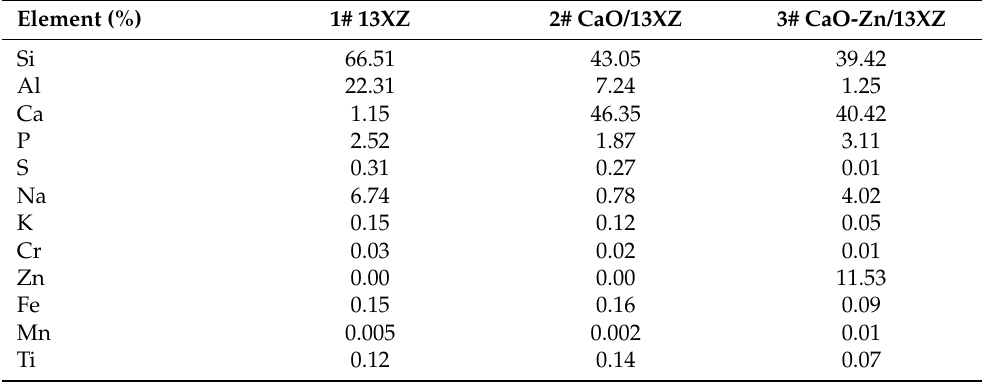
Table 3. The elements composition of the 1# 13XZ, 2# CaO/13XZ and 3# CaO-Zn/13XZ nanomaterials established by EDXRF analysis.